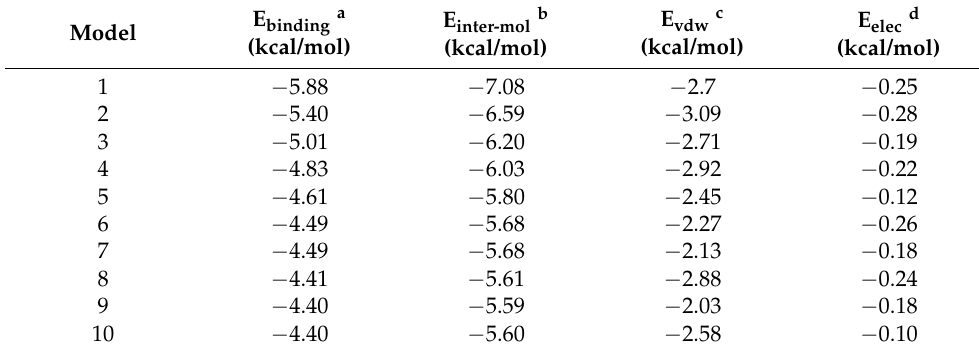
Table 3. Docking results of AutoDock